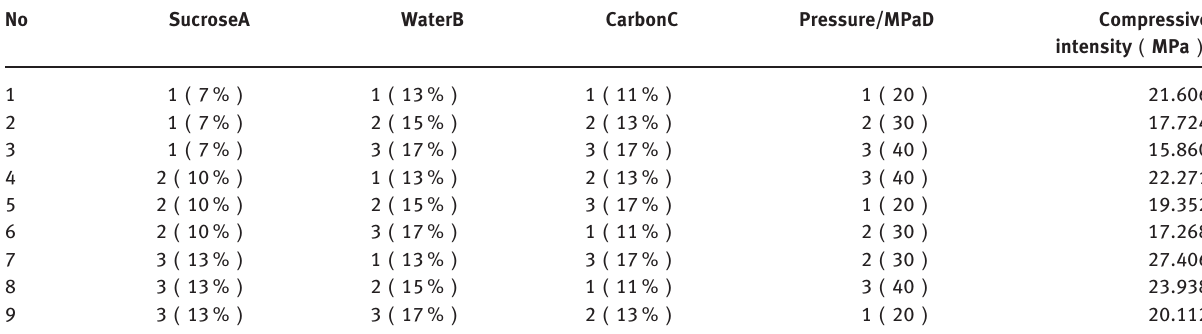
Table 2: Optimization results for the SSD briquetting process.